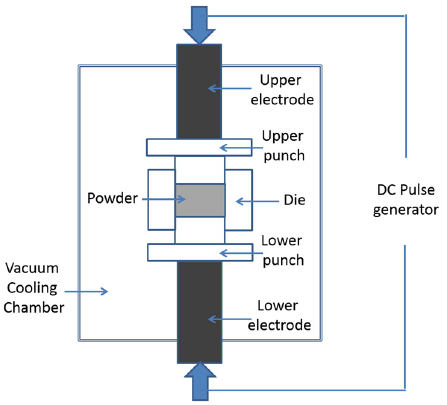
Figure 1. Schematic diagram of mechanical alloying using spark plasma sintering method.